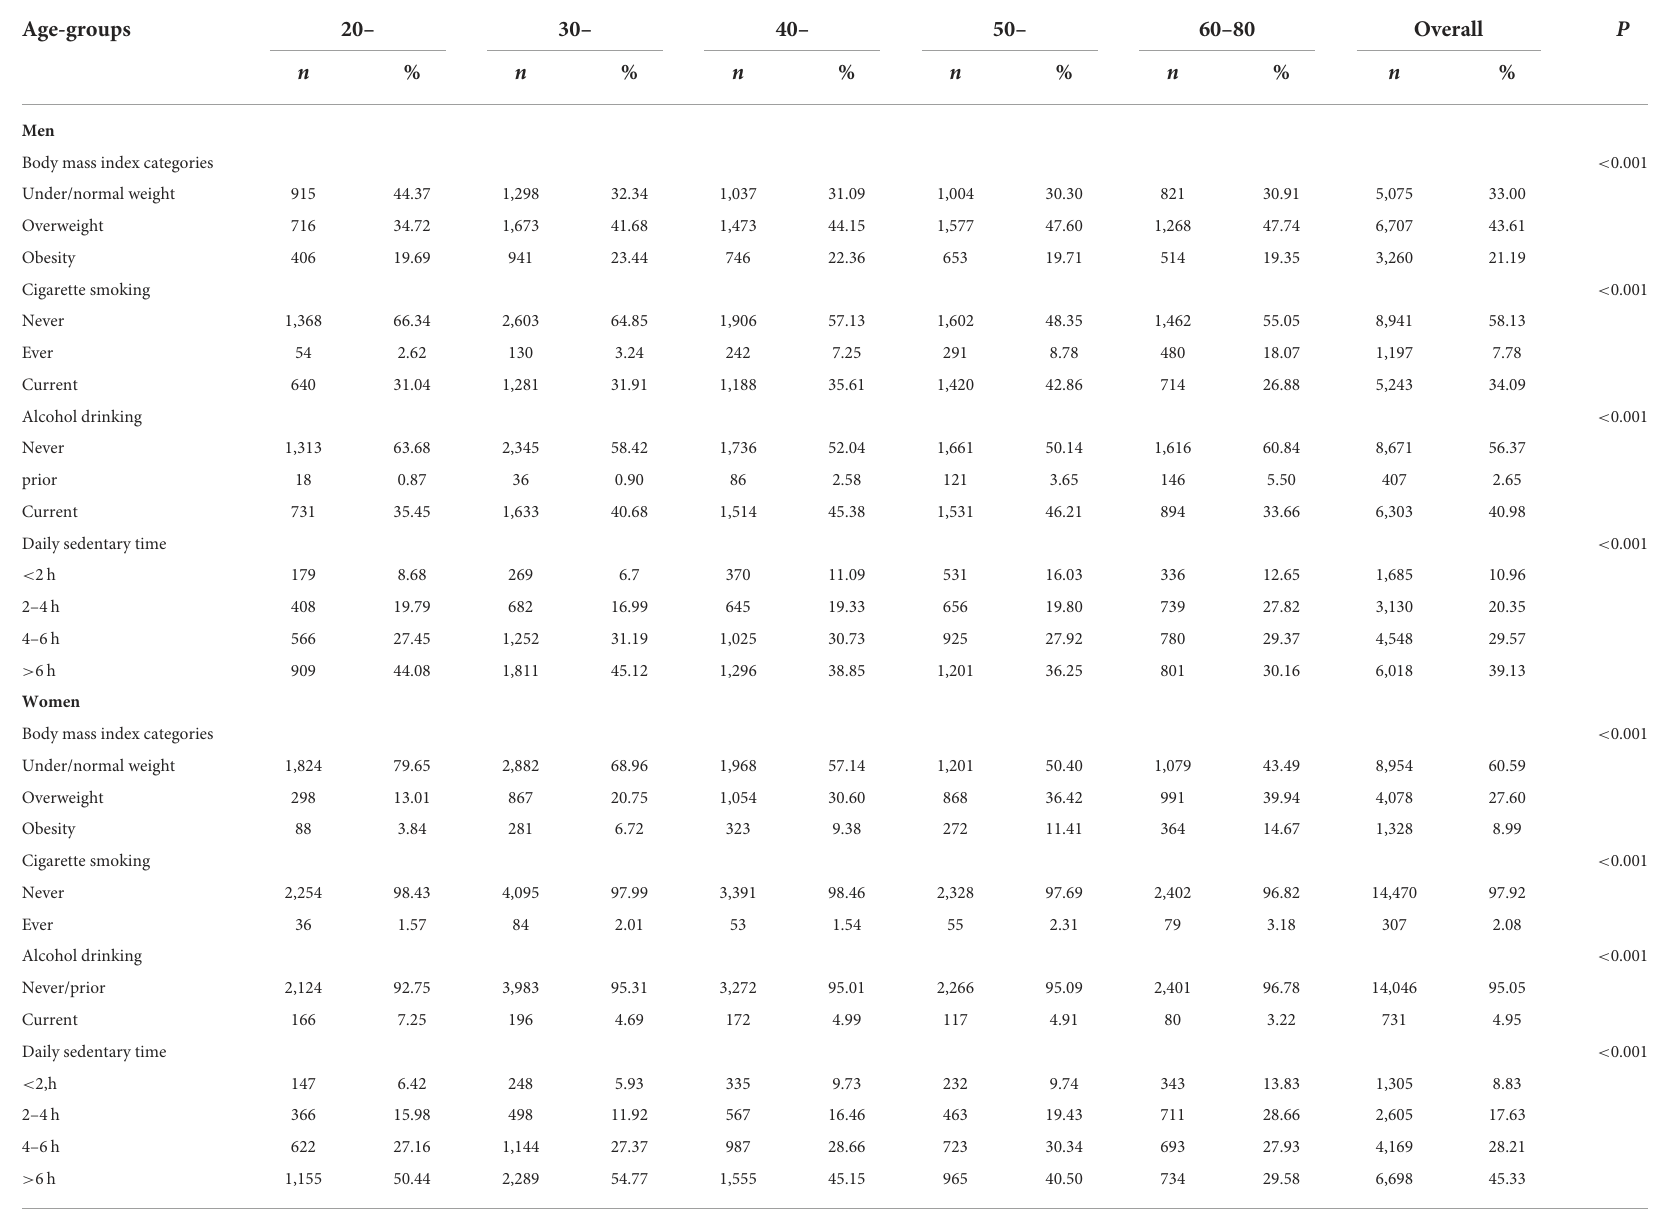
TABLE 2 The distribution of modifiable risk factors in the study population ( n =